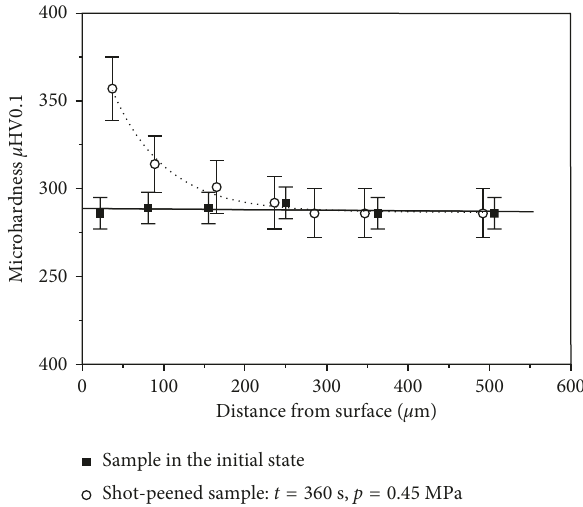
Figure 5: Distribution of microhardness profiles µ HV0.1 in samples before and after shot peening.